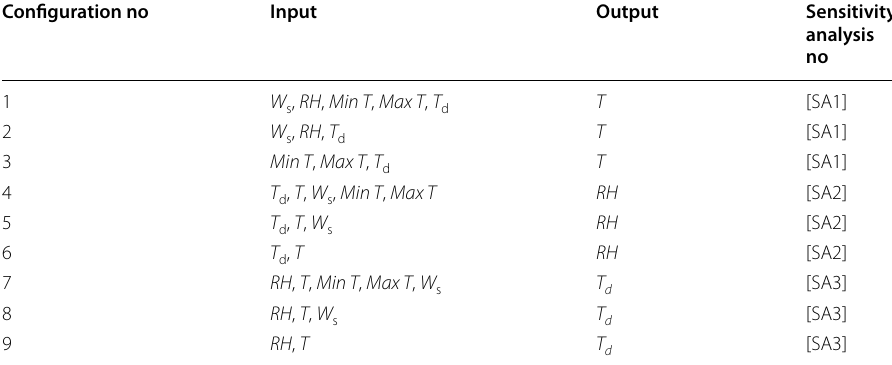
Table 5 Configurations of climate change Configuration